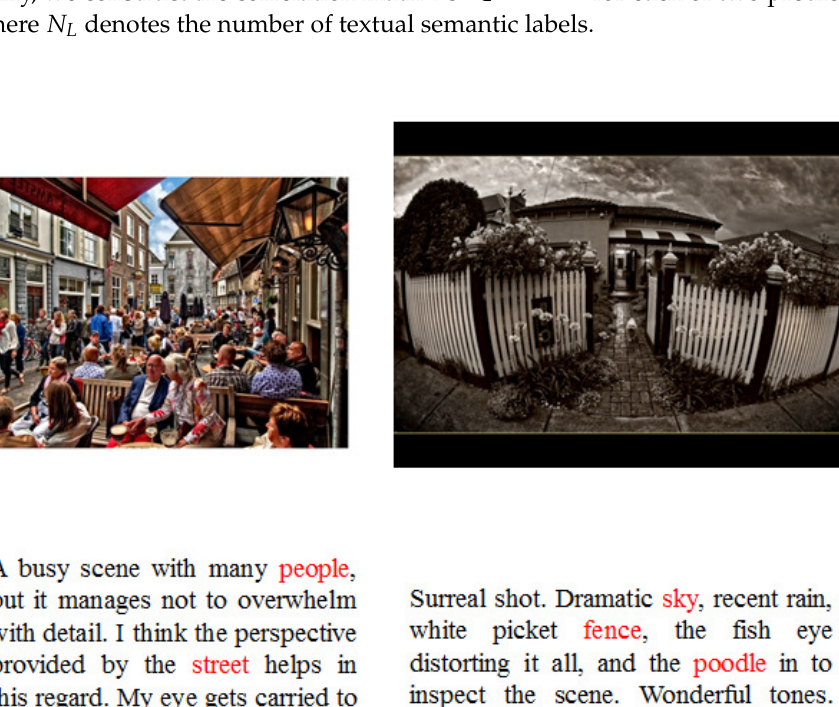
Figure 3. Examples in the AVA-comment dataset. Semantic labels in comments are marked in red.